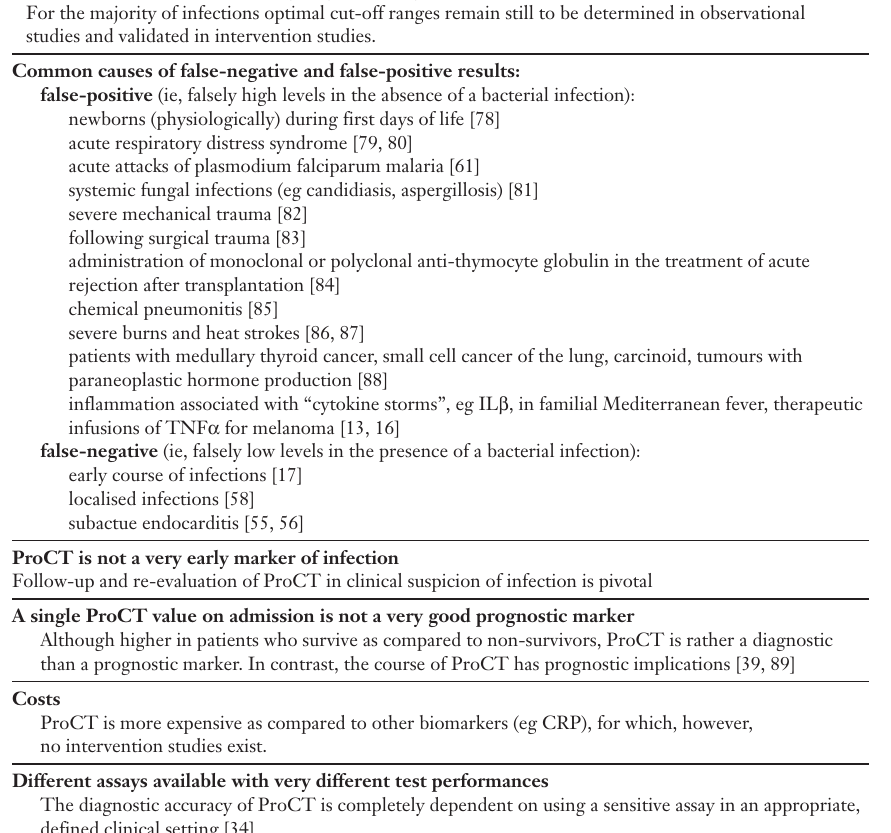
Some potential limi- tations and weak- nesses of ProCT: a research